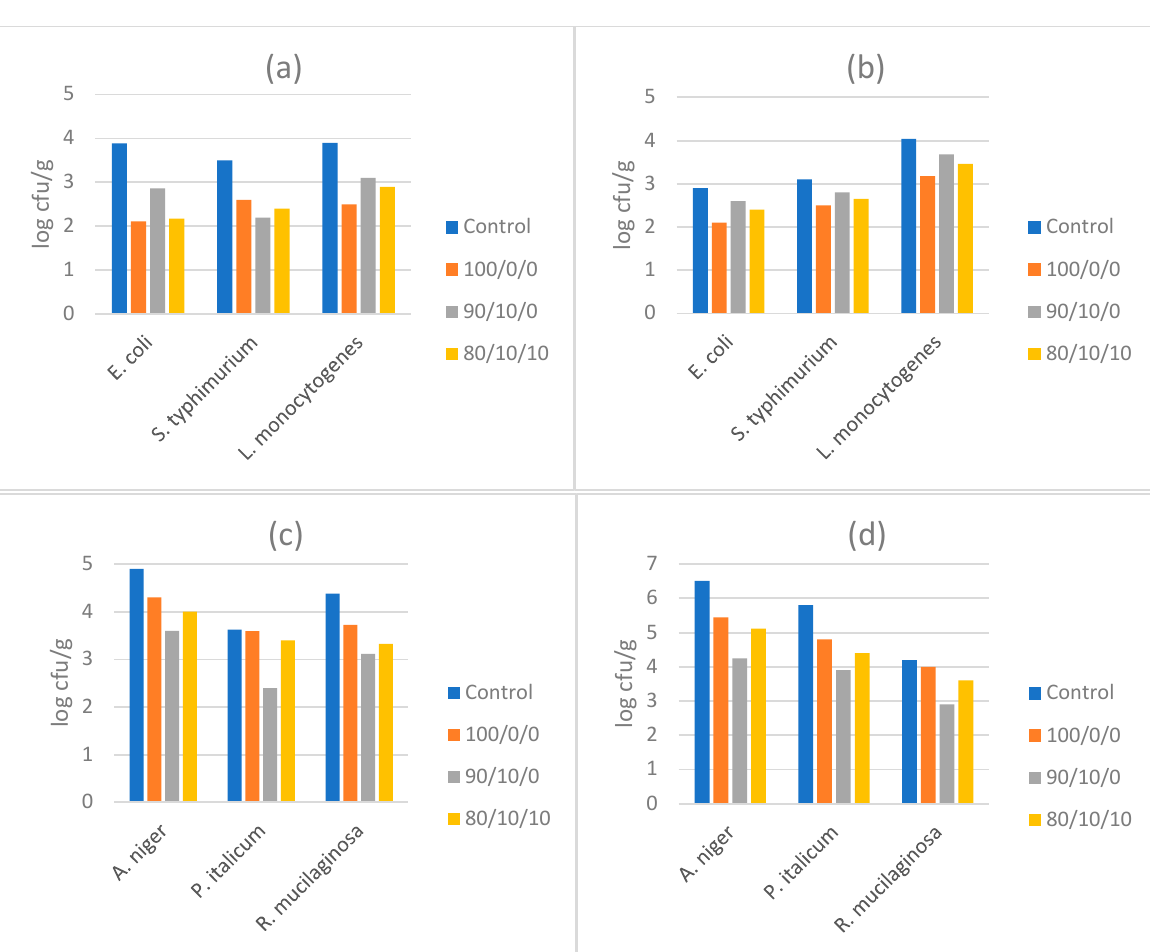
Figure 3. Populations (log cfu/g) of inoculated bacteria and fungi in four different food matrices, in the presence of selected antimicrobial powders, after appropriate storage. ( a ) Fresh burger after 4 days at 4 °C, ( b ) fresh cheese spread after 21 days at 4 °C ( c ) yogurt after 21 days at 4 °C, ( d ) tomato juice after 21 days at 4 °C. (Mean values of triplicate measurements are presented).